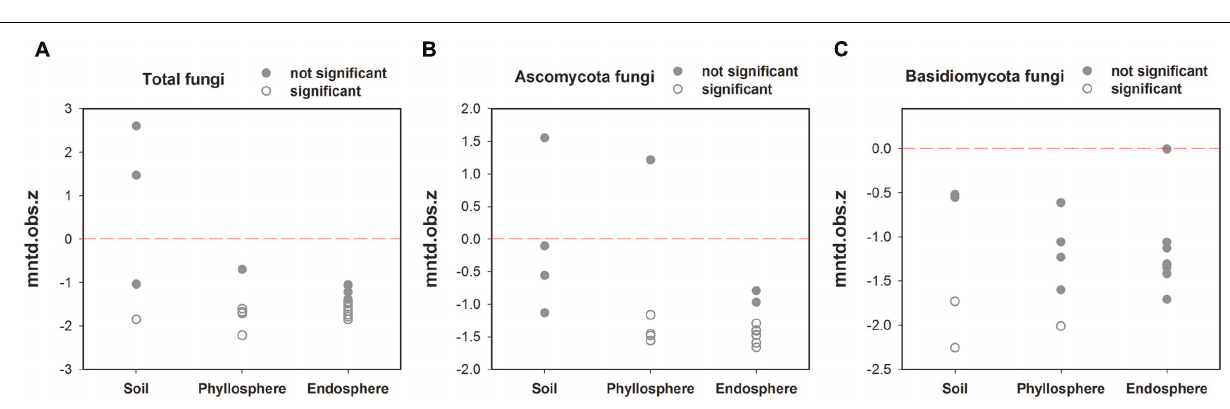
FIGURE 3 | Variation in standardized effect sizes of the mean nearest taxon distance (ses.MNTD) among habitats. (A) Total fungi, (B) Ascomycota fungi, and (C) Basidiomycota fungi. “Not significant”: P > 0.05 and “significant”: P <